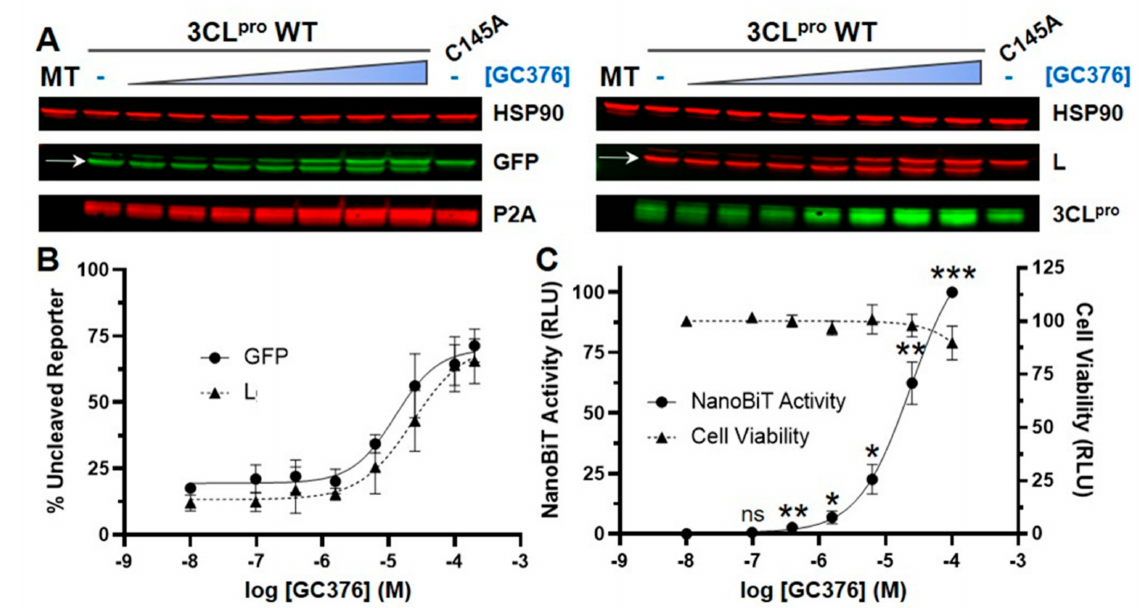
Figure 2. The luciferase complementation assay accurately reflects concentration-dependent inhibition of SARS-CoV-2 3CL pro -mediated cleavage. ( A ) Western blotting to examine reporter cleavage. 293T cells were transfected with the lentiviral vector containing 3CL pro WT and the S-L-GFP reporter cassette, and DMSO (control) or GC376 (0.1, 0.4, 1.6, 6.3, 25, 100, or 200 µ M) was added. Mock transfection (MT) and 3CL pro C145A S-L-GFP were included as controls. On the GFP and LgBiT (L) panels, the bottom band corresponds to cleaved reporter (L-GFP, 46 kDa, indicated by arrows), while the top band corresponds to uncleaved reporter (S-L-GFP, 49 kDa). ( B ) Quantification of the percentage of uncleaved reporter from three independent western blots based on GFP (circle) or L (triangle) detection. ( C ) NanoBiT luciferase activity and cell viability. 293T cells were transfected with the S-L-GFP lentiviral vector, and DMSO (control) or GC376 (0.1, 0.4, 1.6, 6.3, 25, or 100 µ M) was added. NanoBiT activity (circle, left axis) and cell viability (measured with the CellTiter-Glo 2.0 assay; triangle, right axis) were analyzed 30 h post-transfection and are expressed as relative luciferase units (RLU). Cell viability data were normalized to the DMSO sample, which was set to 100%. NanoBiT data were normalized to the DMSO and 100 µ M GC376 samples, which were set to 0 and 100%, respectively. The data represent the mean ± standard deviation of four independent experiments; ns: not significant; * p < 0.05, ** p < 0.01, *** p < 0.001 (relative to no-drug; one-way ANOVA with Dunnett’s